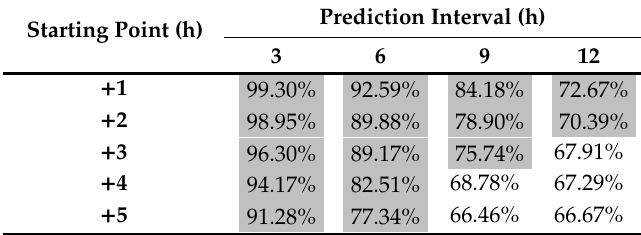
Table 7. Forecast accuracy percentages for the flood event in 2005. This table shows the grid percentages to the total wet grids with average RMSE within 0.3 m. The forecast begins by the starting point, several hours later than the event beginning for the real-time forecast. Starting Point (h)